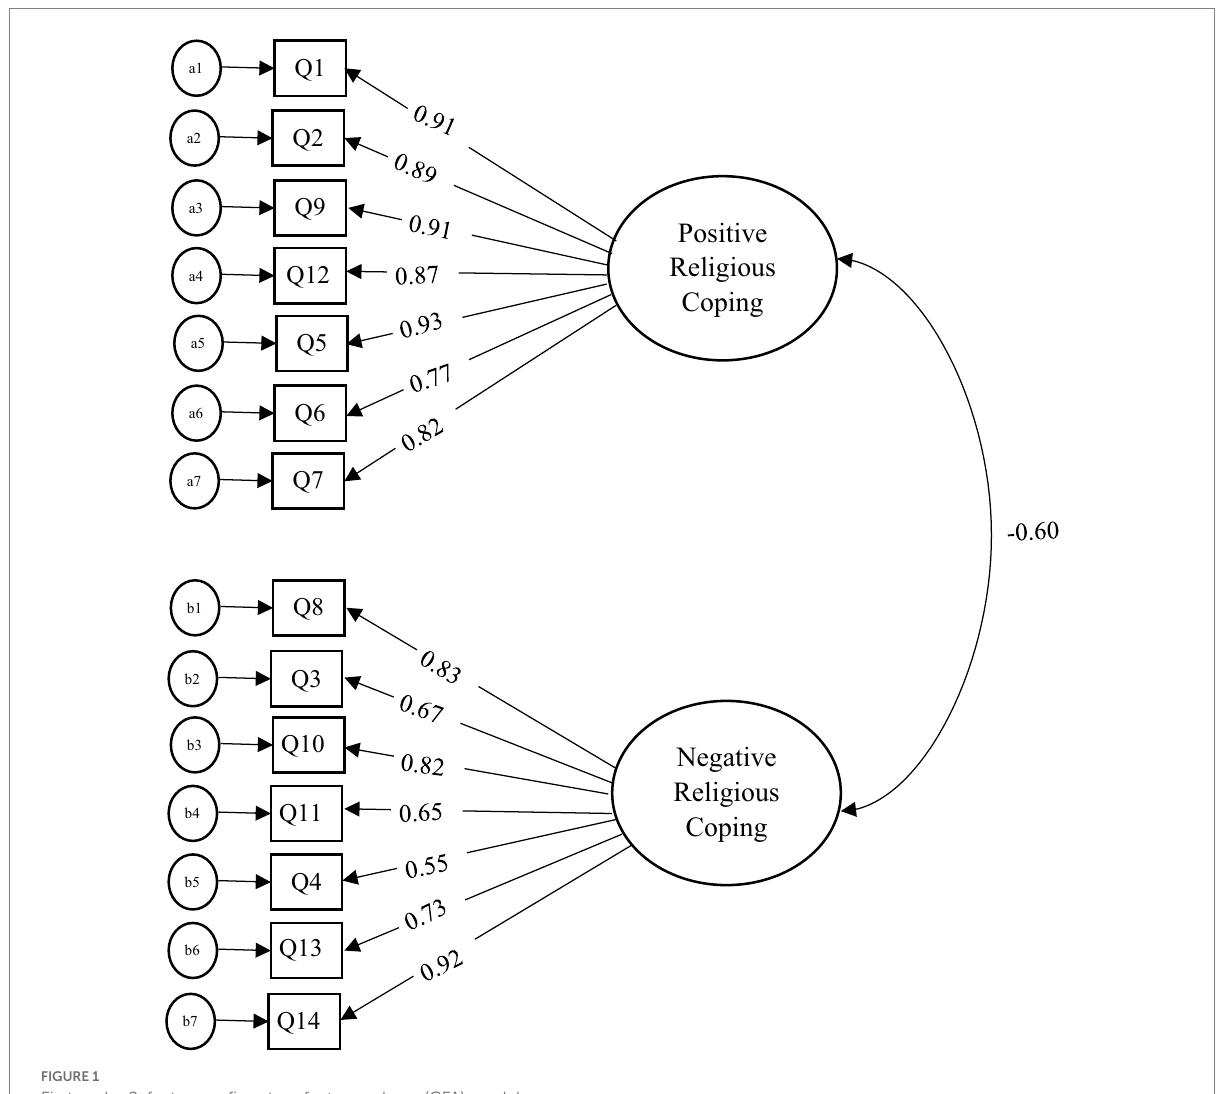
FIGURE 1 First-order 2-factor confirmatory factor analyses (CFA) model.